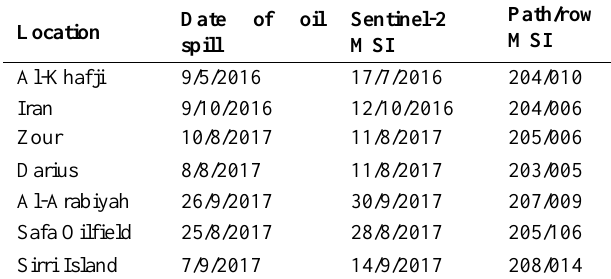
Table 1. Date of satellite imagery used for oil detection in Arabian Gulf